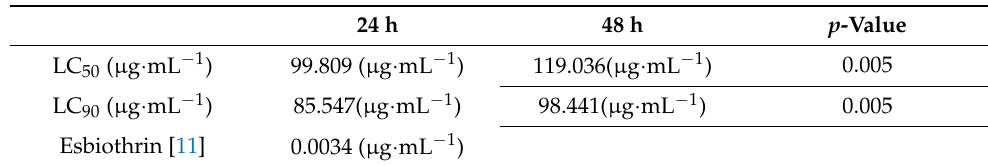
Table 2. The Lethal Concentration of PHEON against A. aegypti